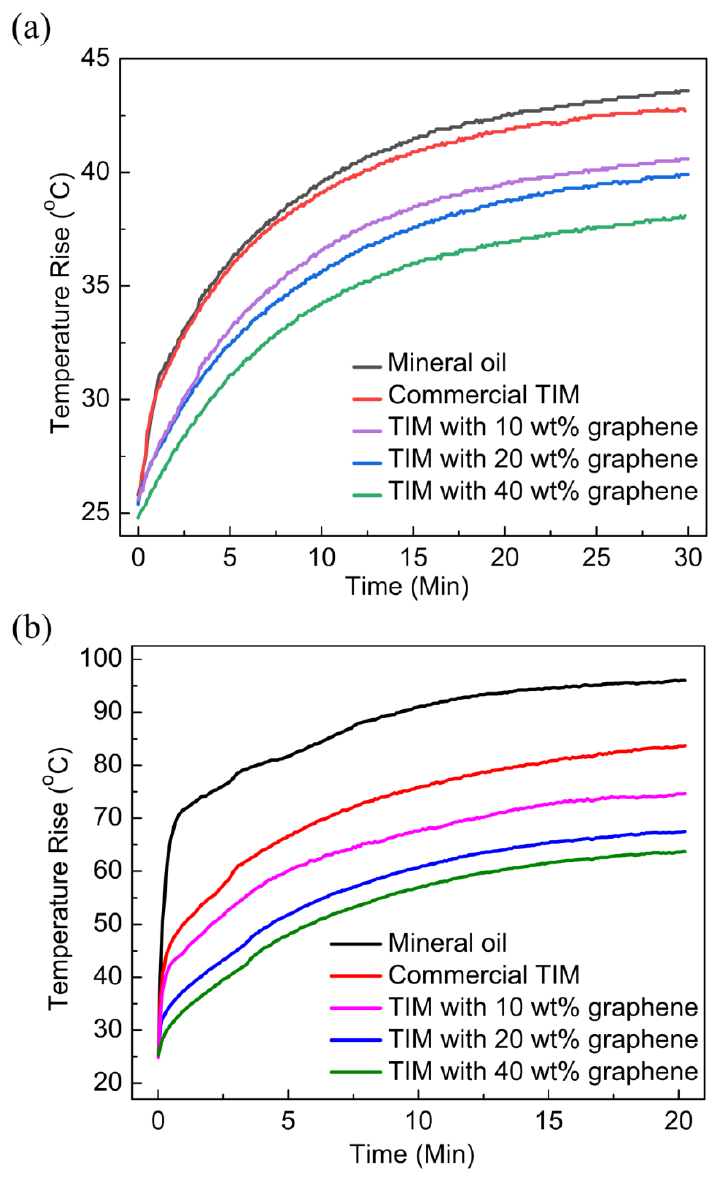
Figure 4. ( a ) Temperature of the solar cell as a function of time under constant illumination of 70× suns and different non-curing TIMs. ( b ) Temperature of the solar cell as a function of time under constant illumination of 200× suns and different non-curing TIMs. Note that TIM with 40 wt% graphene loading shows the least increase in the solar cell temperature owing to better heat dissipation. The results for pure mineral oil and commercial TIM (Ice Fusion) are also shown for comparison.